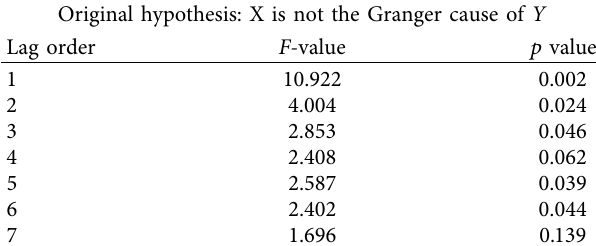
Table 3: Results of Granger Causality